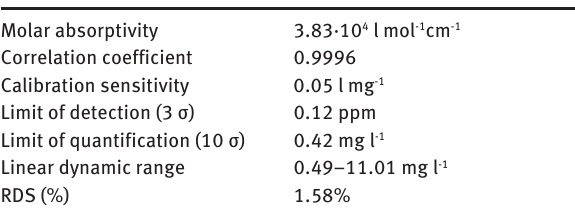
Table 1 Analytical characteristics of the proposed spectrophotometric method. σ , standard deviation; 0.5 cm glass cell; n = 10; approximately 23 °